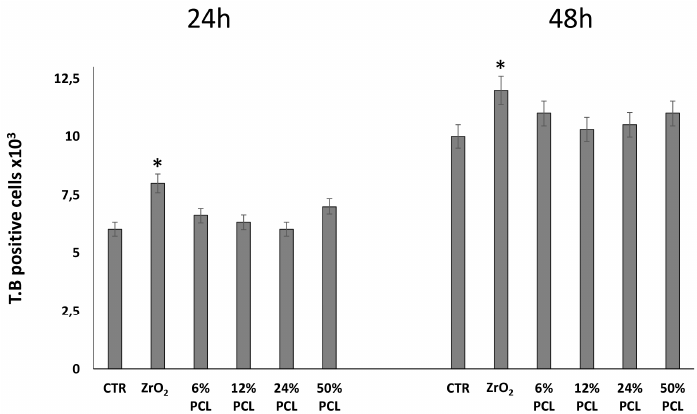
Figure 2. Trypan Blue Exclusion Dye test. NIH-3T3 cells were cultured in 10% serum containing medium in the absence (control, CTR) or presence of PCL-free ZrO 2 and PCL/ZrO 2 hybrid materials with different percentages (6 wt %, 12 wt %, 24 wt %, 50 wt %) for 24 and 48 h. Then, the cell number was recorded as stated in Materials and Methods. Data represent the average of three independent experiments. The means and S.D. are shown. *, p < 0.05 vs. control cells.